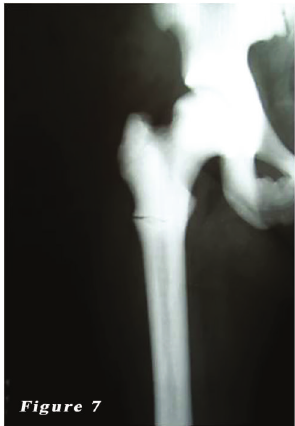
Figure 7: 24-year-old female patient (second case) preoperative radiograph of the right femur subtrochanteric stress fractures.